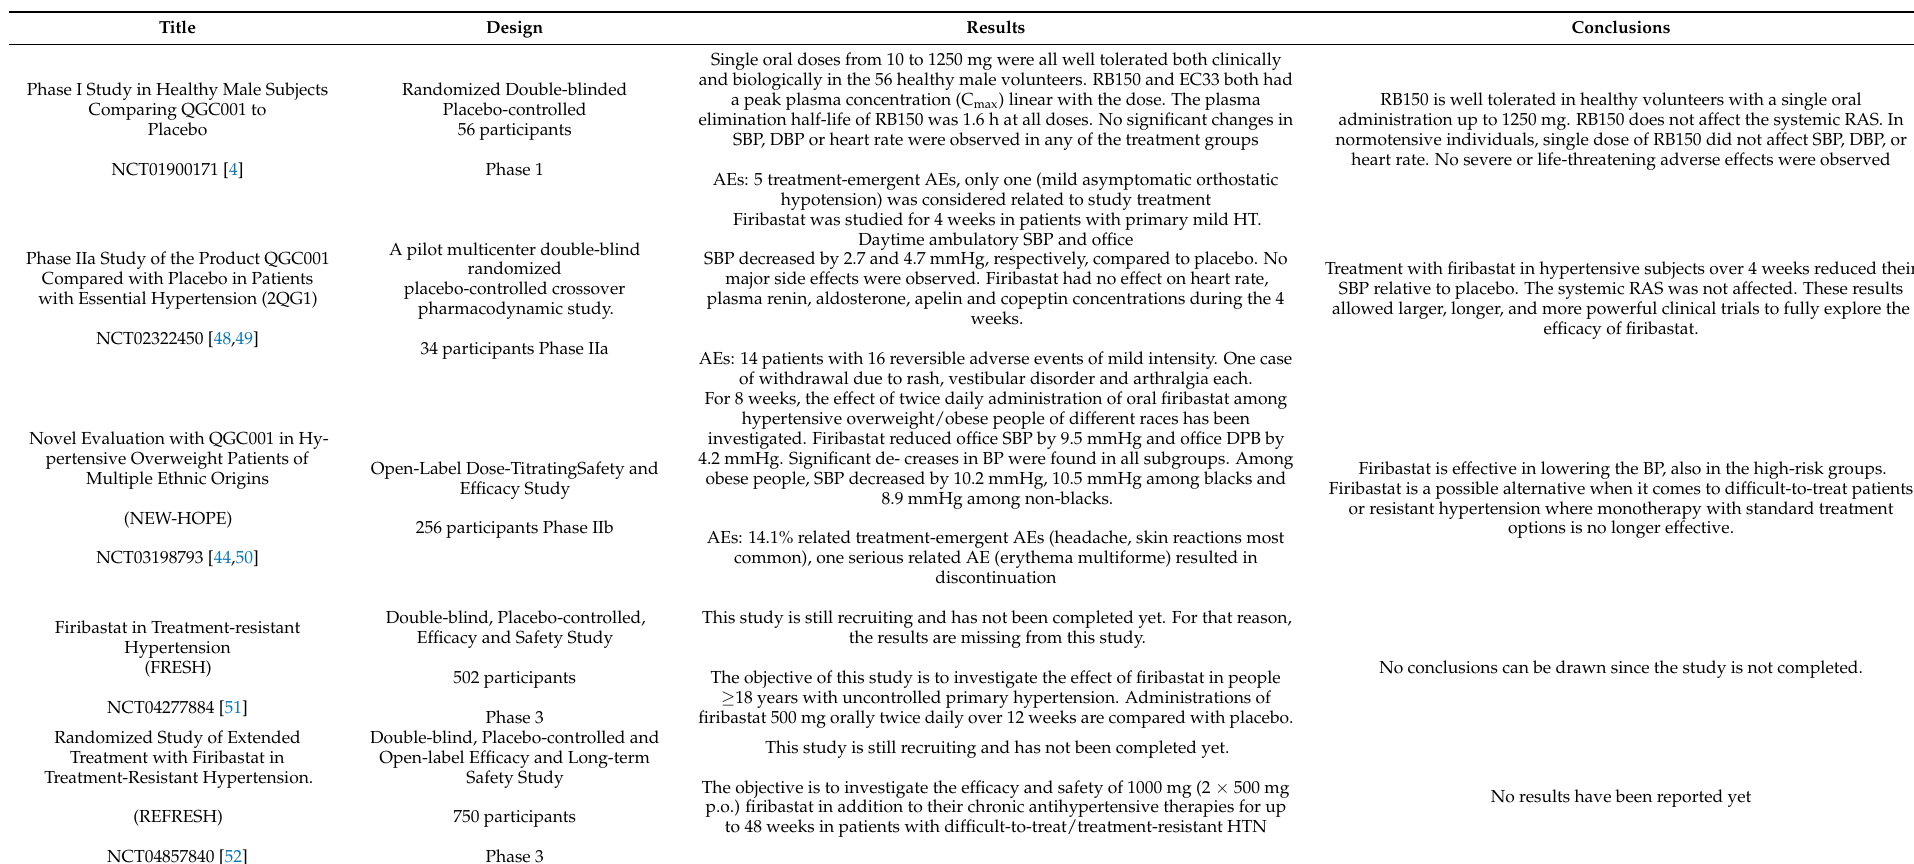
Table 2. Overview of the recent clinical trials using